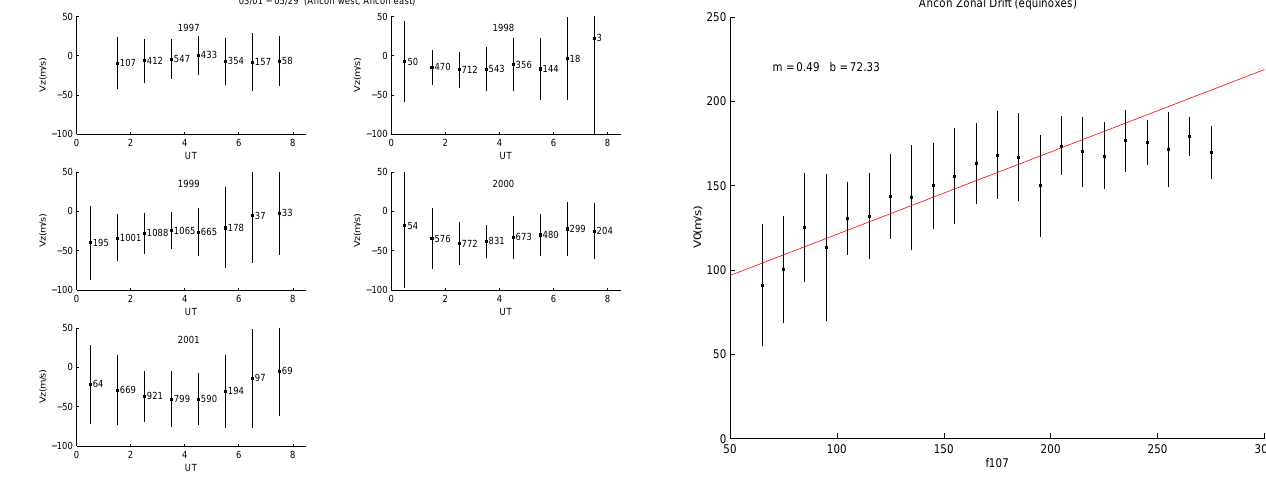
Fig. 10. (b) Same as Fig. 10a except data is from Ancon-W instead of Antofagasta.